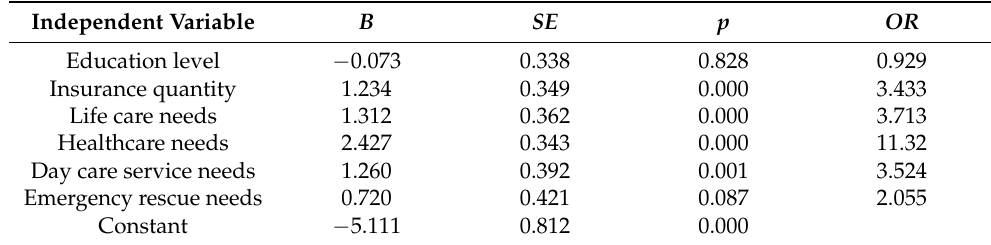
Table 5. Multivariate logistic regression analysis of the factors influencing the elderly’s willingness to select the combined medical care and nursing care model.